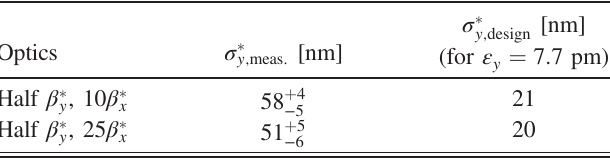
Fig. 9. The obtained value of w ¼ 22 (cid:4) 1 nm